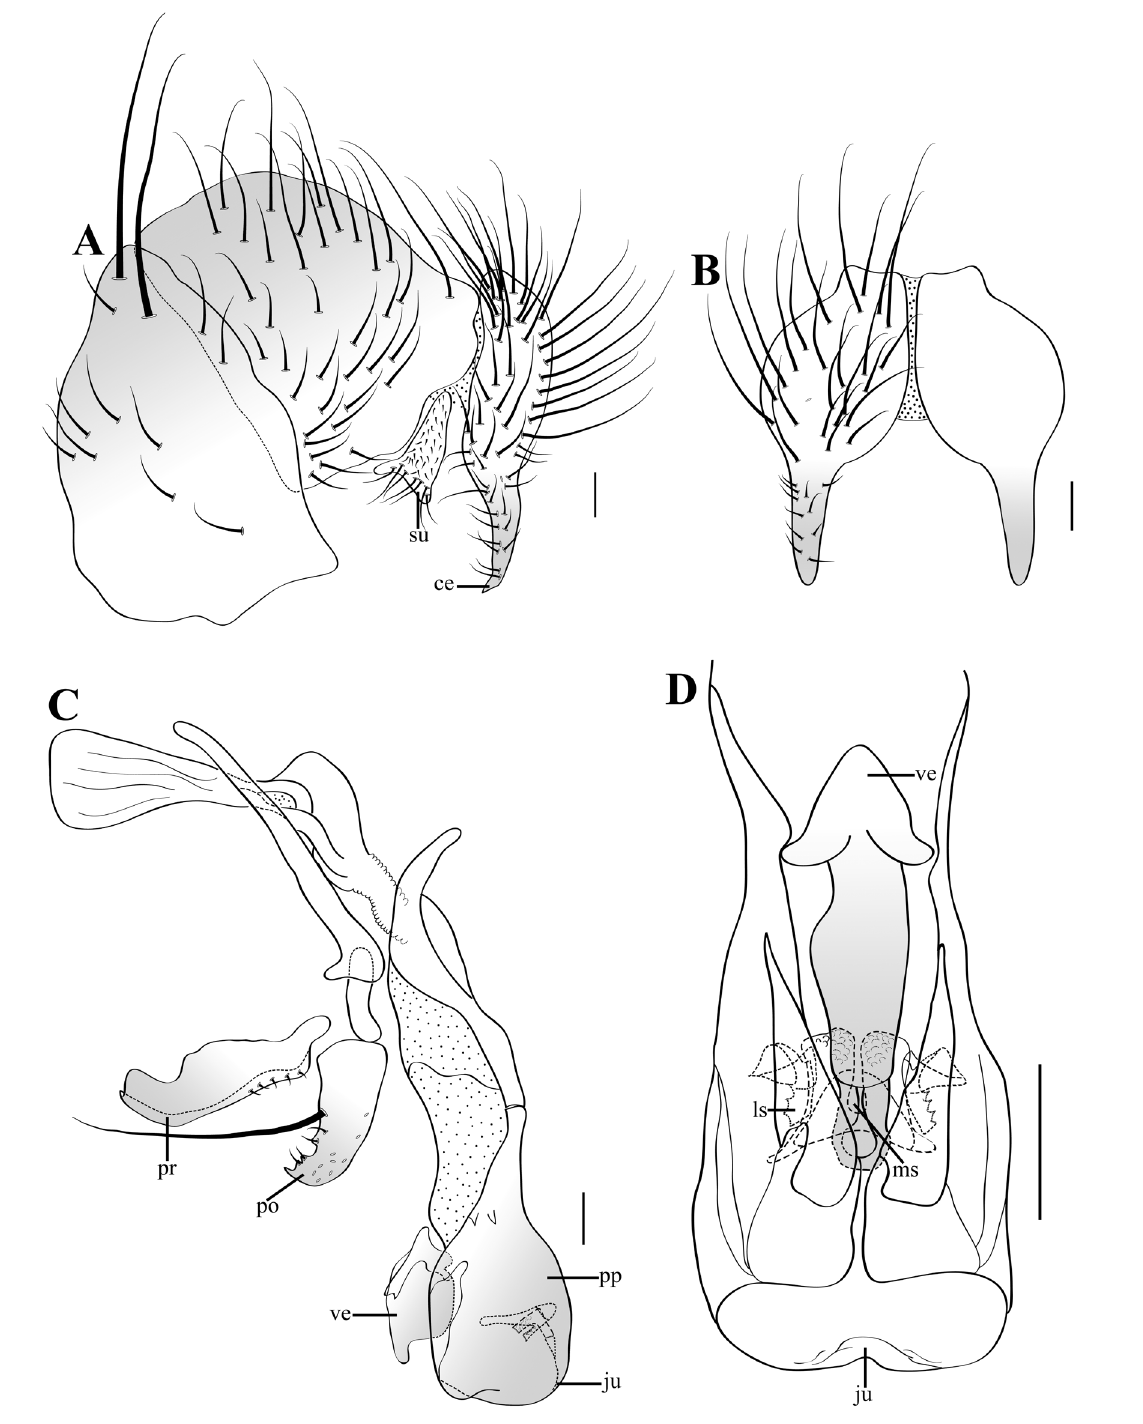
Fig. 5. Dexosarcophaga patiuorum sp. nov., ♂, holotype (MNRJ [lost]). A . Syntergosternite 7 + 8, epandrium, cercus and surstylus, lateral view. B . Cerci, posterior view. C . Phallus and associated structures, lateral view. D . Distiphallus, ventral view. Abbreviations: see Material and methods. Scale bars = 0.1